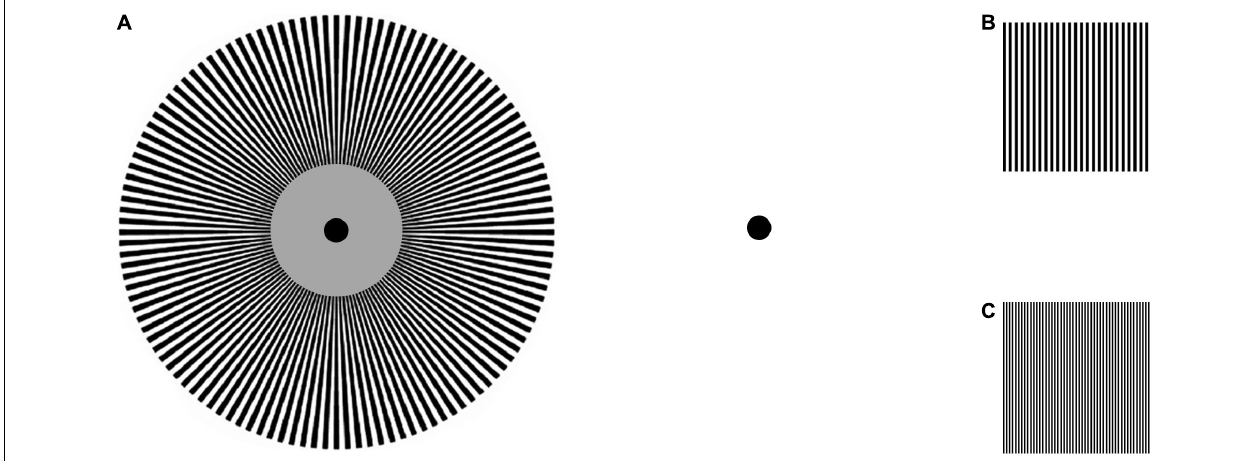
FIGURE 10 | (A) MacKay ray figure, eliciting dancing “chrysanthemum” induction contours approximately orthogonal to the radial bars in the stimulus. Fixate the center of the ray figure for 10 s while rocking the head slightly around the visual axis, then fixate the black dot. A dynamic sheen of circular arcs like a chrysanthemum will be seen circling around the dot. (B,C) Linear gratings illustrating that the angle of the induced rays varies with the spatial frequency of the inducing